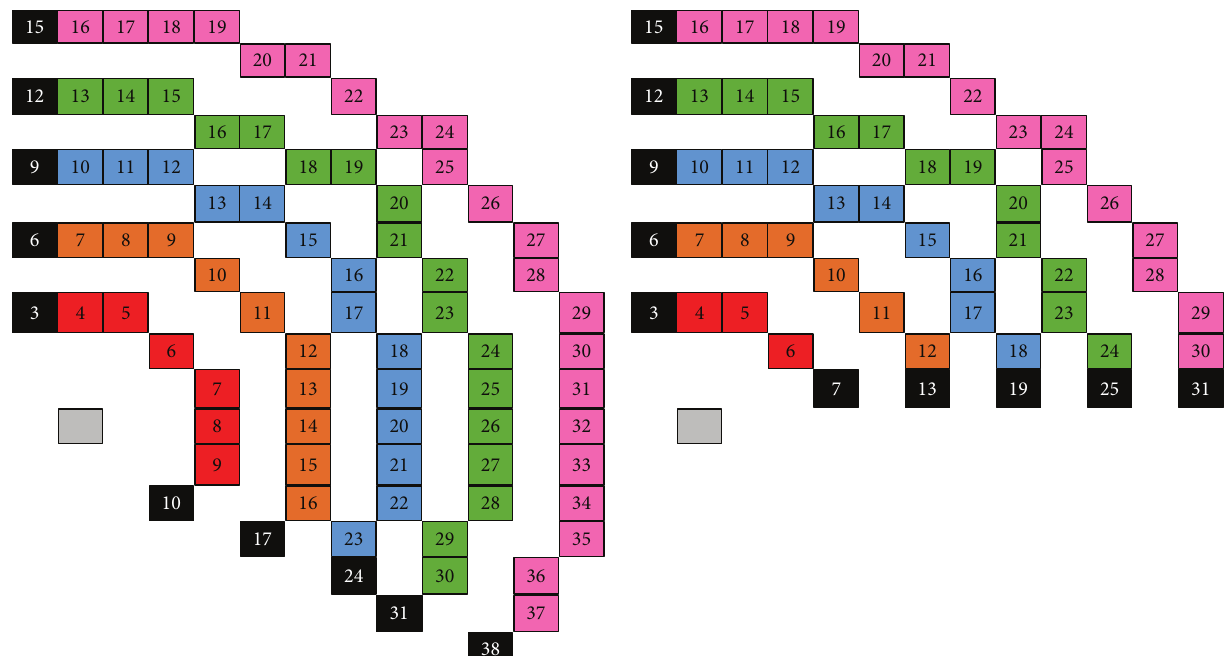
Figure 3: Two corner points with different angles and, therefore, different arc lengths for